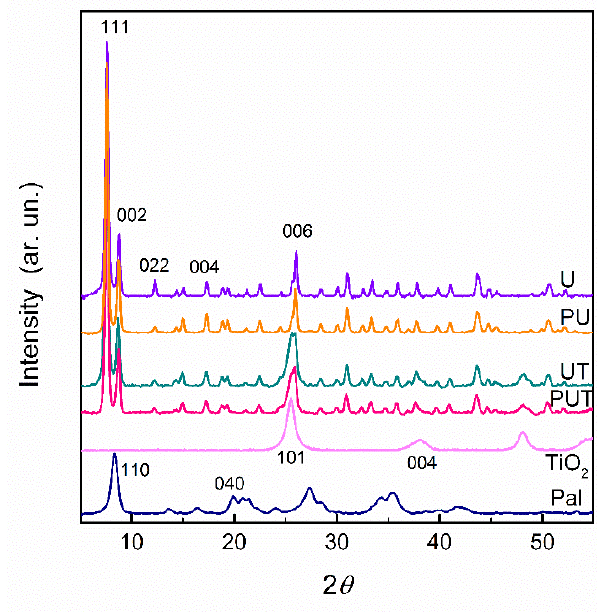
Figure 1. XRD patterns of the pure and composite materials.